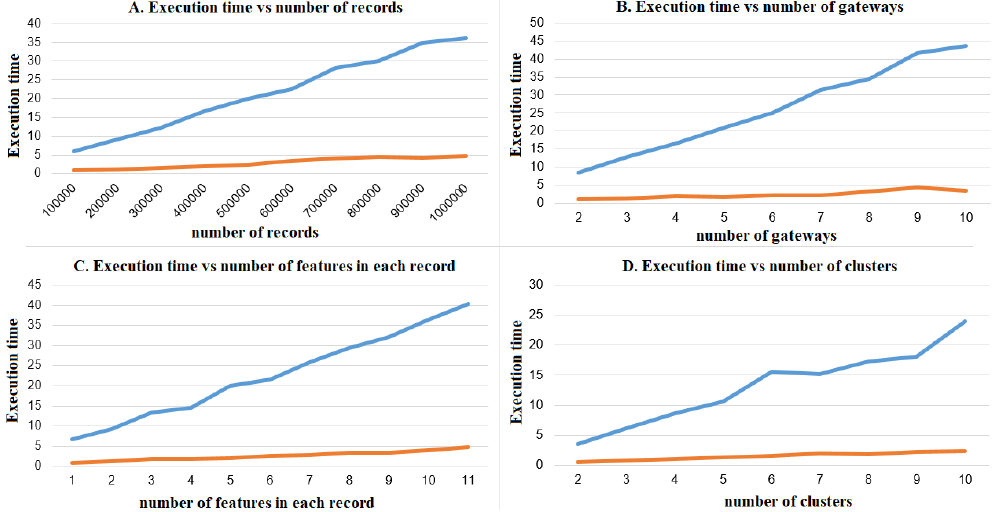
Figure 7. Execution time ( x axis of all four plots, in seconds) of the privacy-preserving clustering algorithm on PC (orange) and gateway (blue), in ( A ) for a different number of records ( y axis, the number of records), in ( B ) for a different number of gateways ( y axis, the number of gateways), in ( C ) for a different number of features ( y axis, the number of features in each record processed by the clustering algorithm), and in ( D ) for a different number of clusters ( y axis, the number of